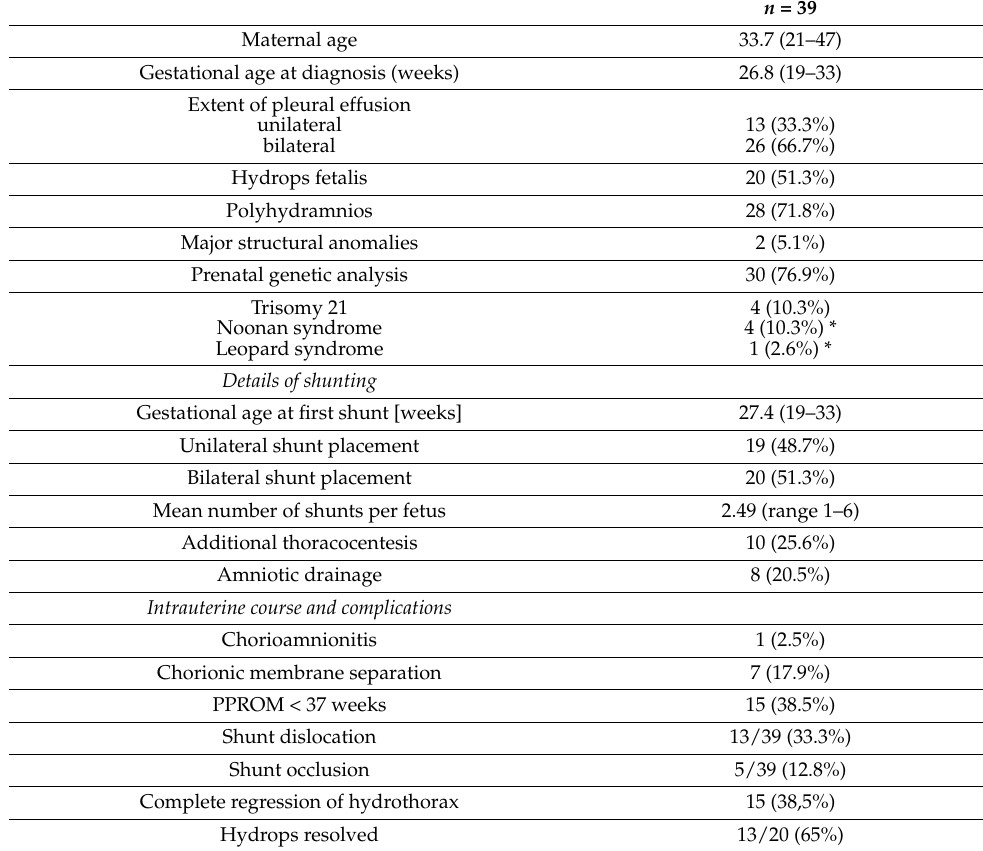
Table 1. Patient characteristics of fetuses treated with thoracoamniotic